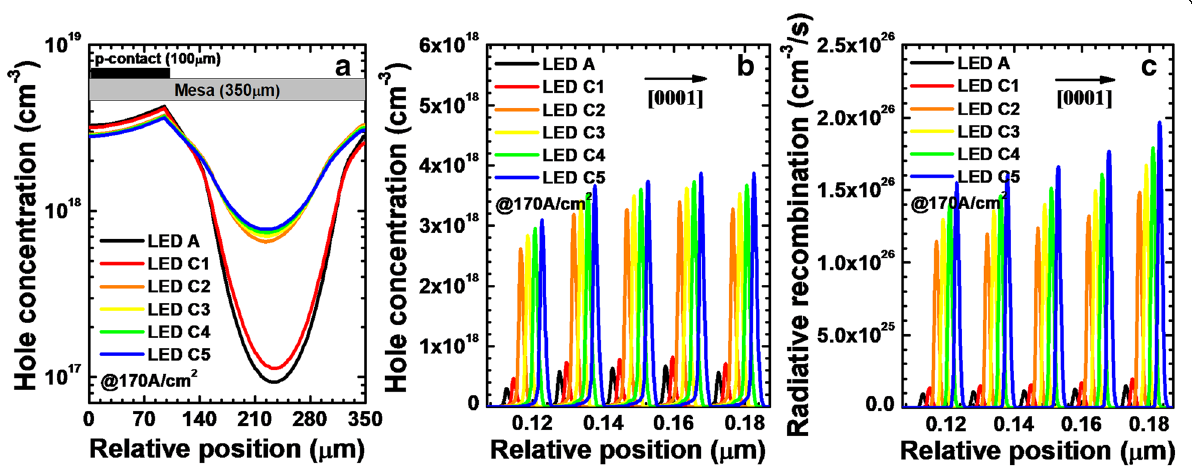
Fig. 6 a Horizontal hole concentration in the LQW, b hole concentration levels, and c radiative recombination profiles in the MQWs for LEDs A and D i ( i = 1, 2, 3, 4, and 5) when the current density is 170 A/cm 2 . We purposely shift the curves for b and c by 2 nm for easier identification